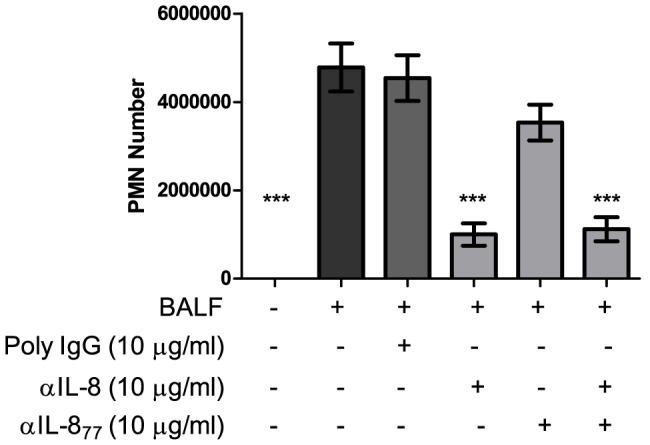
Neutrophil chemotaxis to preterm BALF.Chemotaxis of adult human neutrophils to pooled BALF from BPD infants after incubation for 60 min. Conditions are detailed on the x-axis while concentration of neutrophils (cells/ml) are expressed on the y-axis. Bars are at means (± SEM) of three independent experiments, each done in triplicate. Conditions were compared by one-way ANOVA with Dunnet's correction, comparing against a control column (BALF only). (*** = p<0.001).